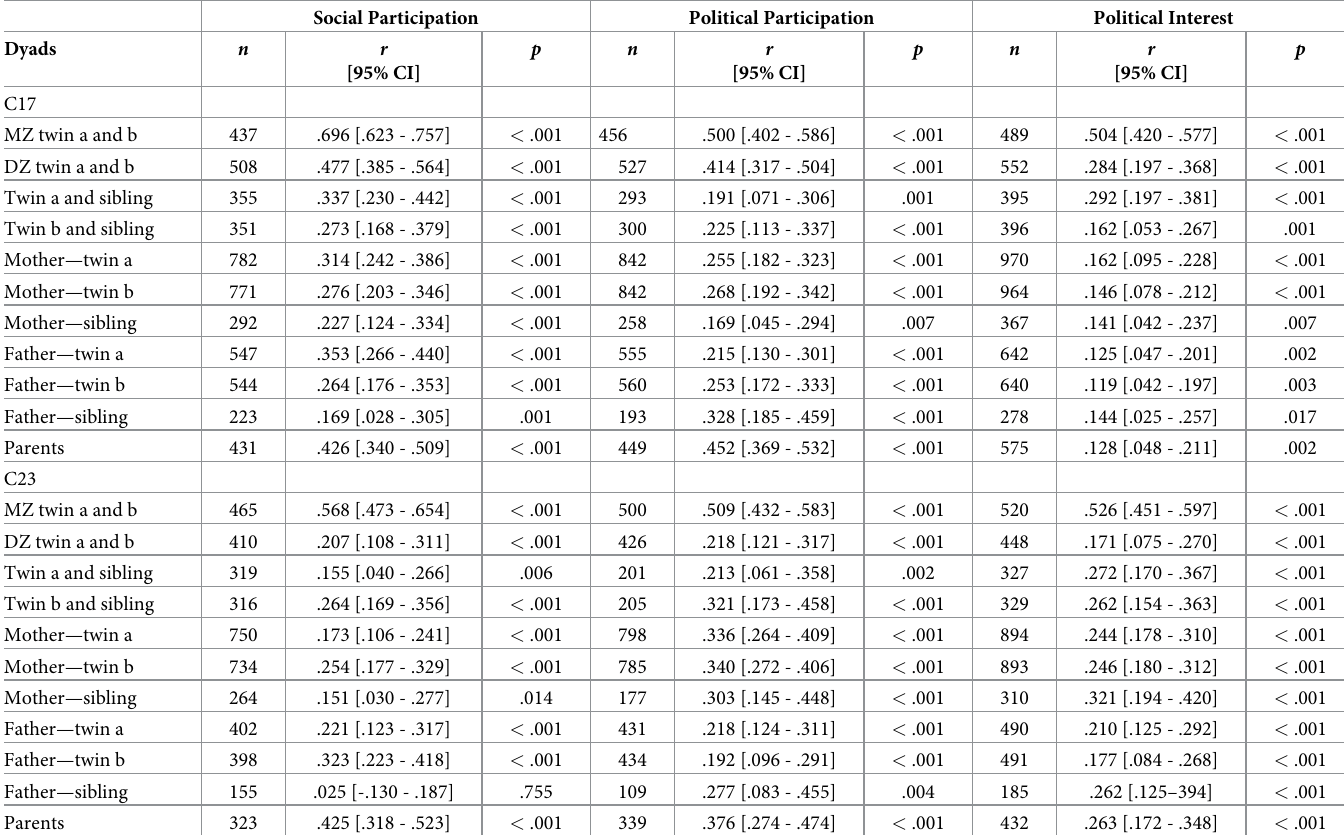
Table 2. Family correlations for all